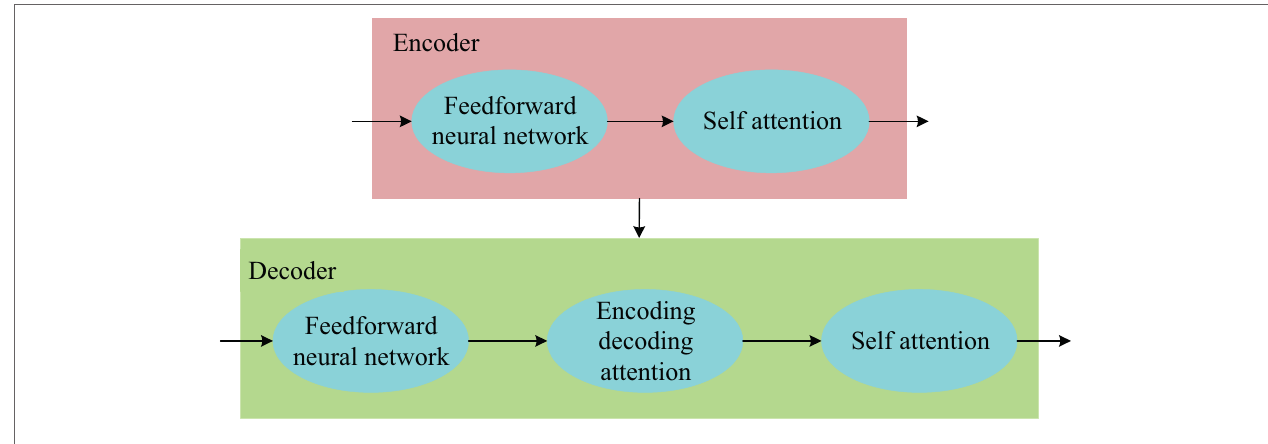
FIGURE 2 | Partial structure of encoder and